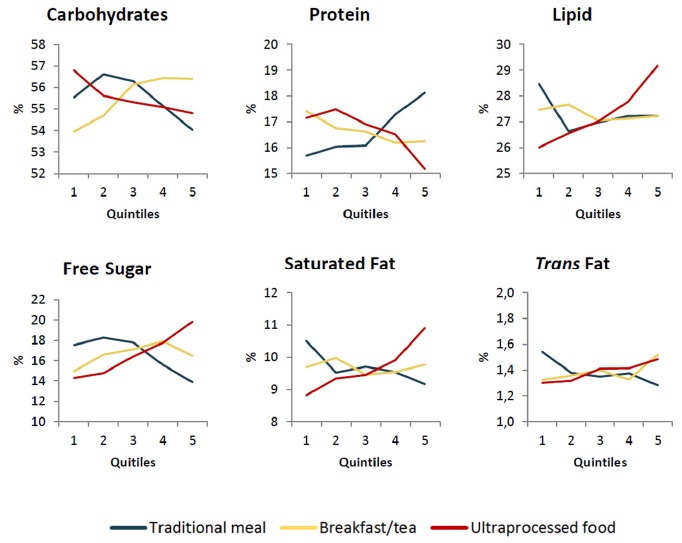
Figure 1. Predicted values of carbohydrates, protein, lipid, free sugar, saturated fat and trans fat percentage according to fifths participation in eating out pattern scores, adjusted for personal, sociodemographic and socioeconomic characteristics and the percentage of calories consumed outside of the home. Brazilian population aged 10 and up (2008–2009).